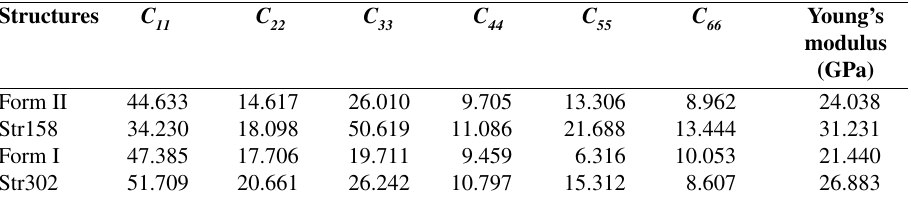
Table 4: Comparison of the mechanical properties of the ab initio predicted benzocaine crystal structure and experimental polymorphs of Benzocaine at 0K. Structures